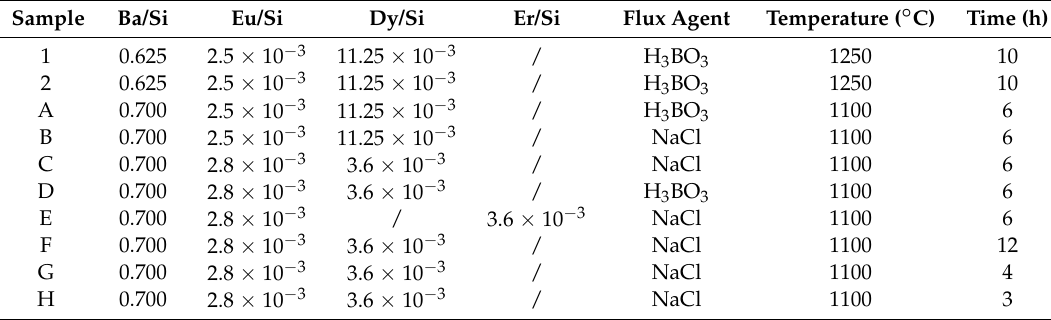
Table 1. Theoretical molar ratios and synthesis conditions of